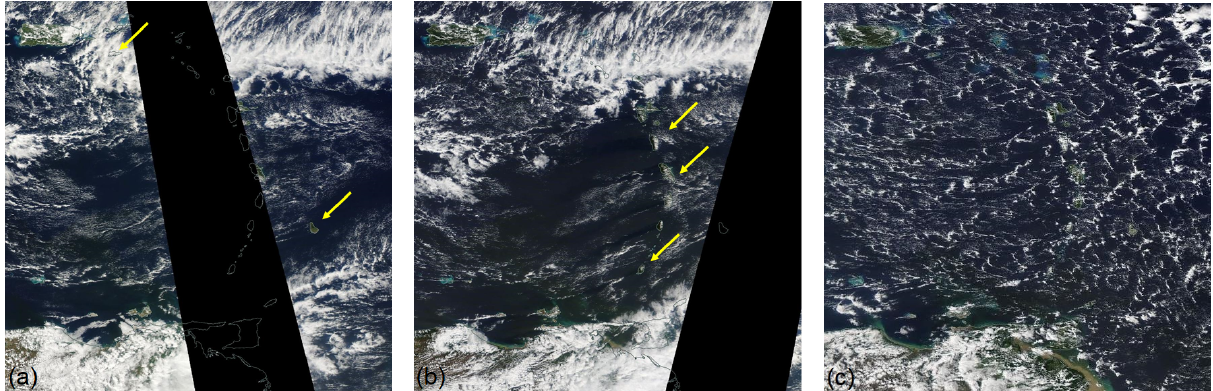
Figure 10. Visible image from (a) MODIS Aqua and (b) Terra, on 19 January 2020, and (c) MODIS Aqua, on 13 January 2020, depict- ing different cloud organization over the study domain (8.9–19.1 ◦ N, 57.4–67.6 ◦ W). The yellow arrows locate St. Croix (northwest) and Barbados (southeast) in the upper left image, and Guadeloupe, Martinique, and Grenada (from north to south) in the upper right image. In the lower image, a Gravel cloud organization is observed uniformly across the domain on 13 January 2020. Source: NASA WorldView